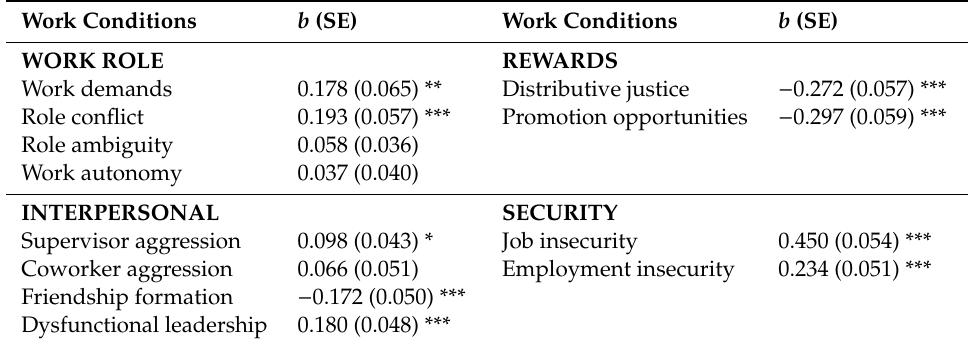
Table 2. Unstandardized path coe ffi cients relating organizational downsizing to work conditions